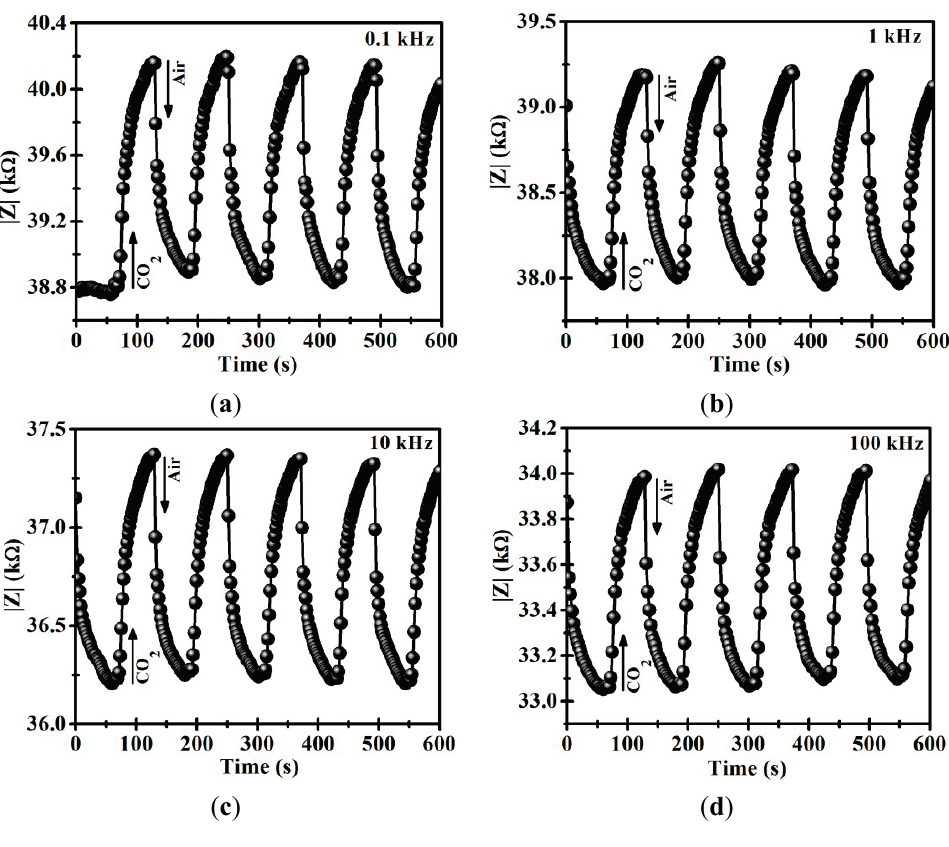
O oxide subjected to CO 2 6